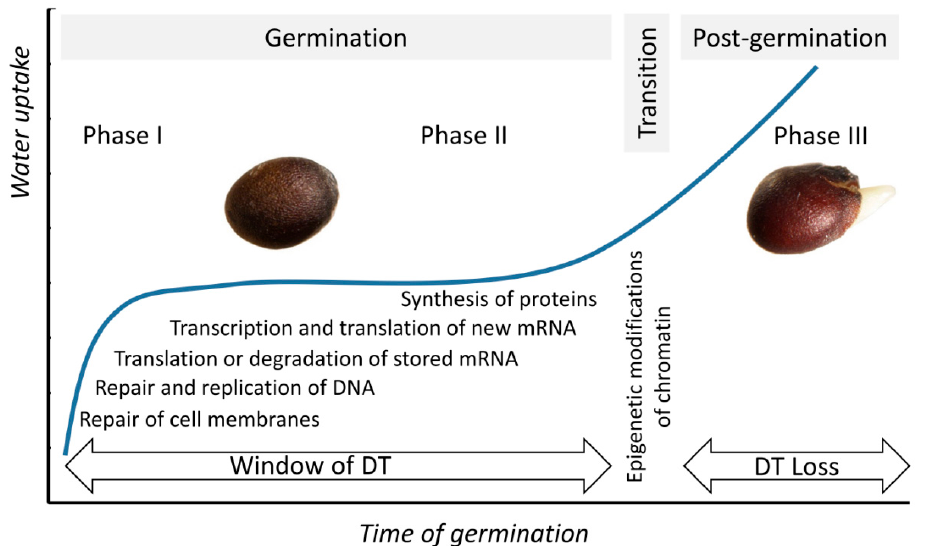
Figure 1. Time course of seed germination. The overall germination times vary from hours to weeks, depending on plant species and environmental conditions. Phase I is characterized by rapid water uptake, accompanied with enhanced hydration of macromolecules, activation of respiration, repair of membranes, mitochondria, and DNA. Phase II is characterized by mobilization of reserves, translation of stored mRNAs, transcription and translation of newly synthesized mRNAs, and activation of protein biosynthesis. The radicle protrusion is considered as the beginning of Phase III. Epigenetic changes (methylation of DNA, as well as trimethylation, ubiquitination, and acetylation of histones), occurring in this phase, result in silencing of the genes related to seed maturation and triggering expression of the genes responsible for vegetative growth of seedlings. “Window of DT (desiccation tolerance)” can be defined as the part of the overall germination period, when seeds can be dried back to their original water contents without a decrease of their viability. Transition from germination to the post-germination stage corresponds to loss of